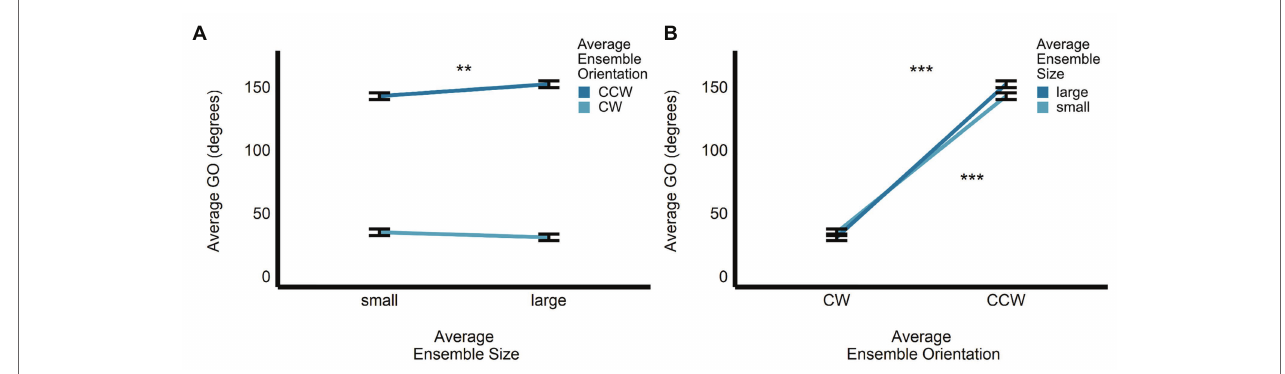
FIGURE 5 | Univariate results of the size-by-orientation interaction for GO in the perceptual orientation-discrimination task. Differences in the estimated marginal means of GO are plotted for (A) small vs. large average size, for CW and CCW ensemble displays, and (B) CW vs. CCW average orientation, for small and large ensemble displays. ** p < 0.005, *** p < 0.0001; error bars depict SEM; GO, grip orientation; CW, clockwise; CCW, counter-clockwise.